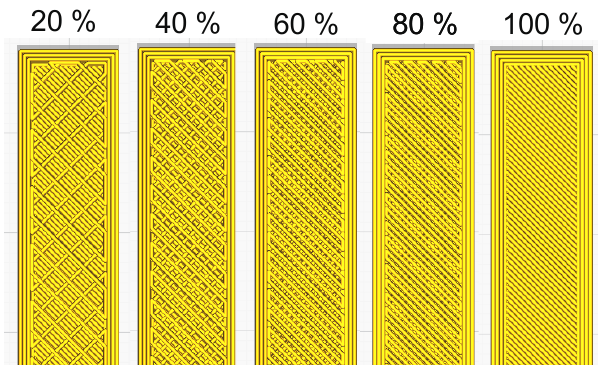
Figure 2. View of the Zig Zag pattern depending on the percentage of infill.